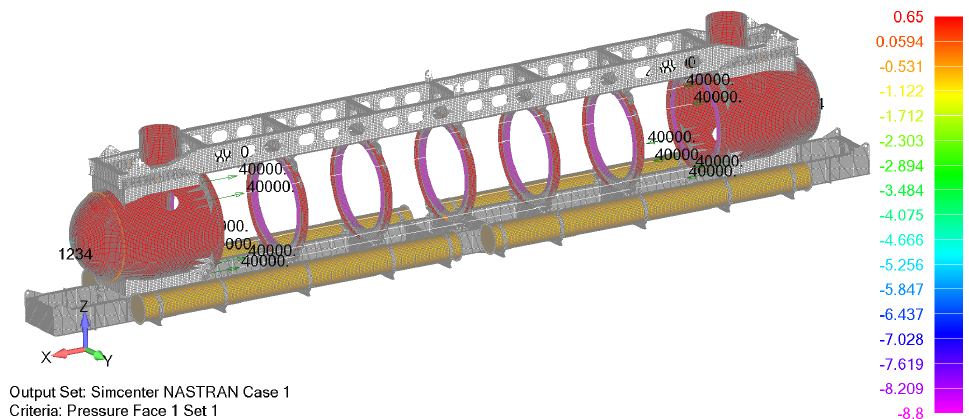
Figure 6. Loads and boundary conditions on the submarine structural assembly (force in N, pressure